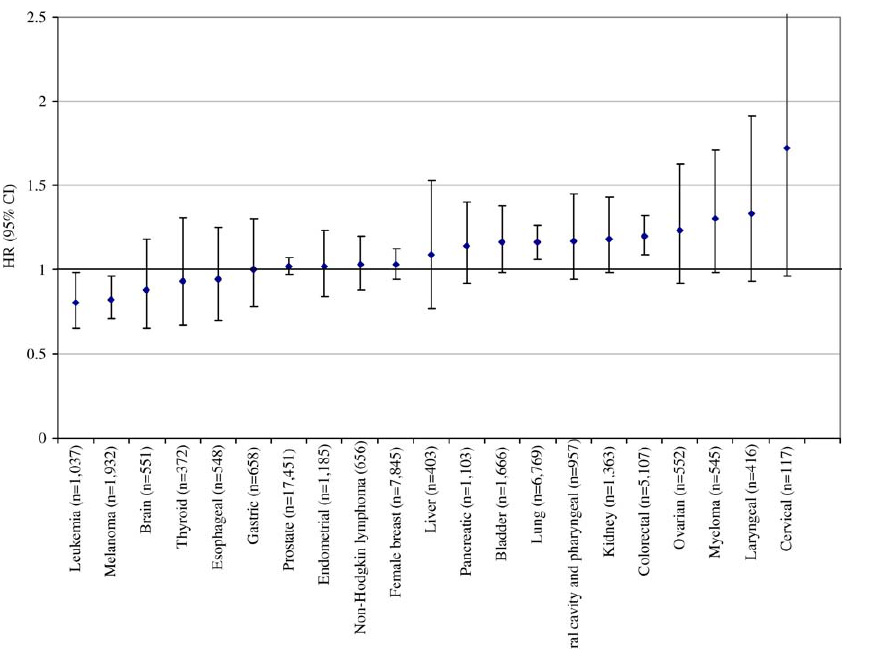
Figure 2. HRs and 95% CIs for the 5th Versus 1st Quintile of Processed Meat Intake and Cancer Risk for Both Sexes Combined (Except for Sex-Specific Cancers)